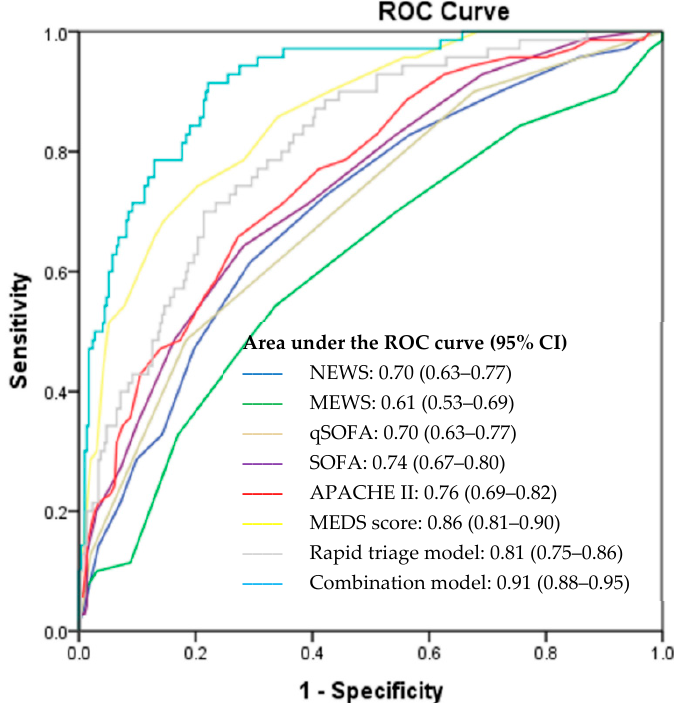
Figure 2. Receiver operator characteristic (ROC) curves for the prediction of 30-day IHM. APACHE II: Acute Physiology and Chronic Health Evaluation II; CI: confidence interval; IHM: in-hospital mortality; MEDS: Mortality in Emergency Department Sepsis; MEWS: Modified Early Warning Score; NEWS: National Early Warning Score; qSOFA: Quick Sequential Organ Failure Assessment; ROC: receiver operating characteristic; SOFA: Sequential Organ Failure Table 4. Performance of scoring systems for the prediction of 30-day IHM.